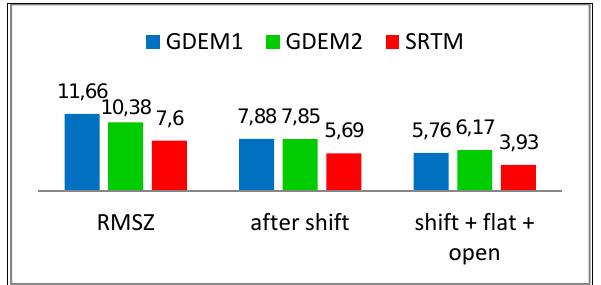
Figure 6: root mean square RMSZ for 12 test areas